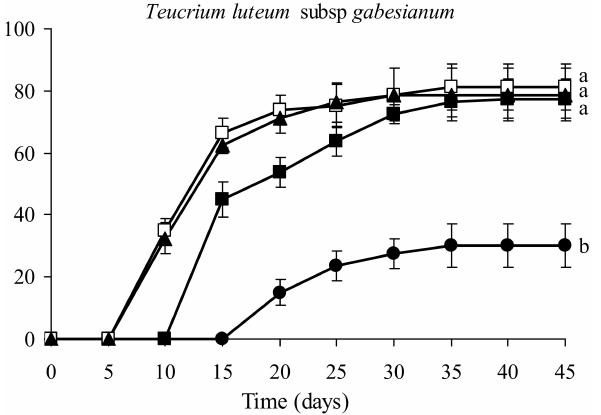
Figure 7. Cumulative seed germination percentage diagrams of Teucrium luteum subsp. gabesianum seeds incubated at different temperatures ( • 10 ◦ C, (cid:4) 15 ◦ C, (cid:3) 20 ◦ C, and (cid:78) 25 ◦ C). After Duncan’s test, means with different letters are statistically different at p < 0.05.